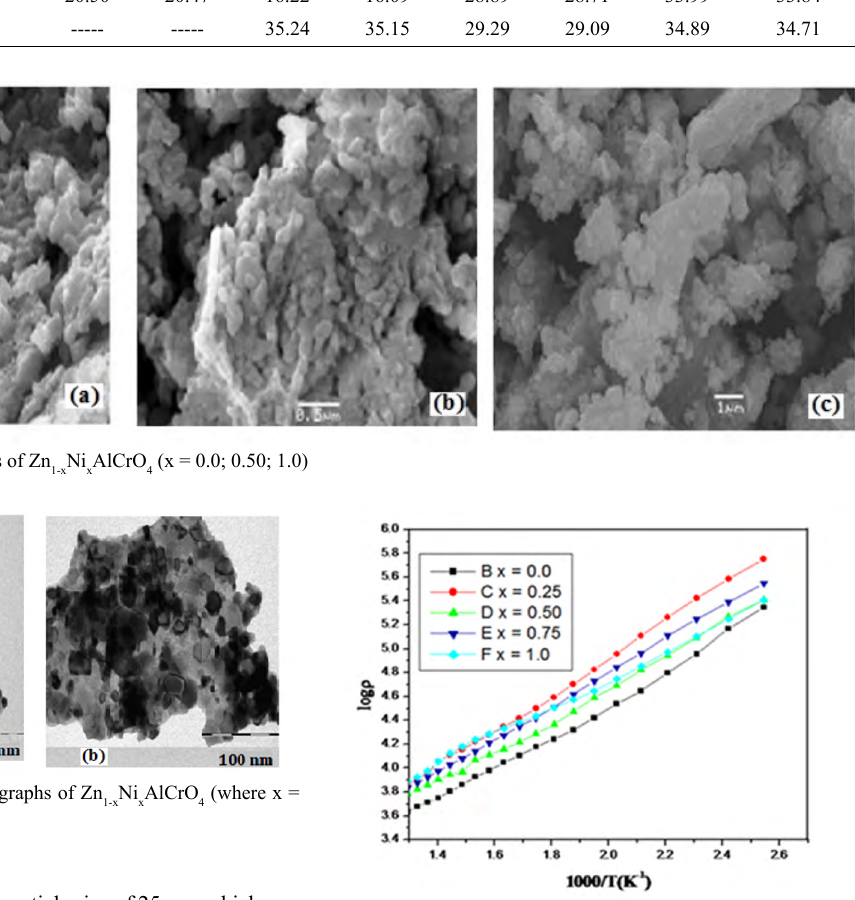
Figure 6. Variations in D.C. resistivity (log ρ) with temperature (1000/T) of Zn Ni AlCrO 1-x x